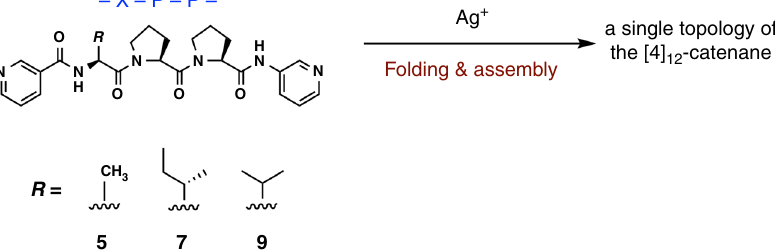
Fig. 4 Examination of ligands 5 , 7 , and 9 for the [4] 12 -catenane formation